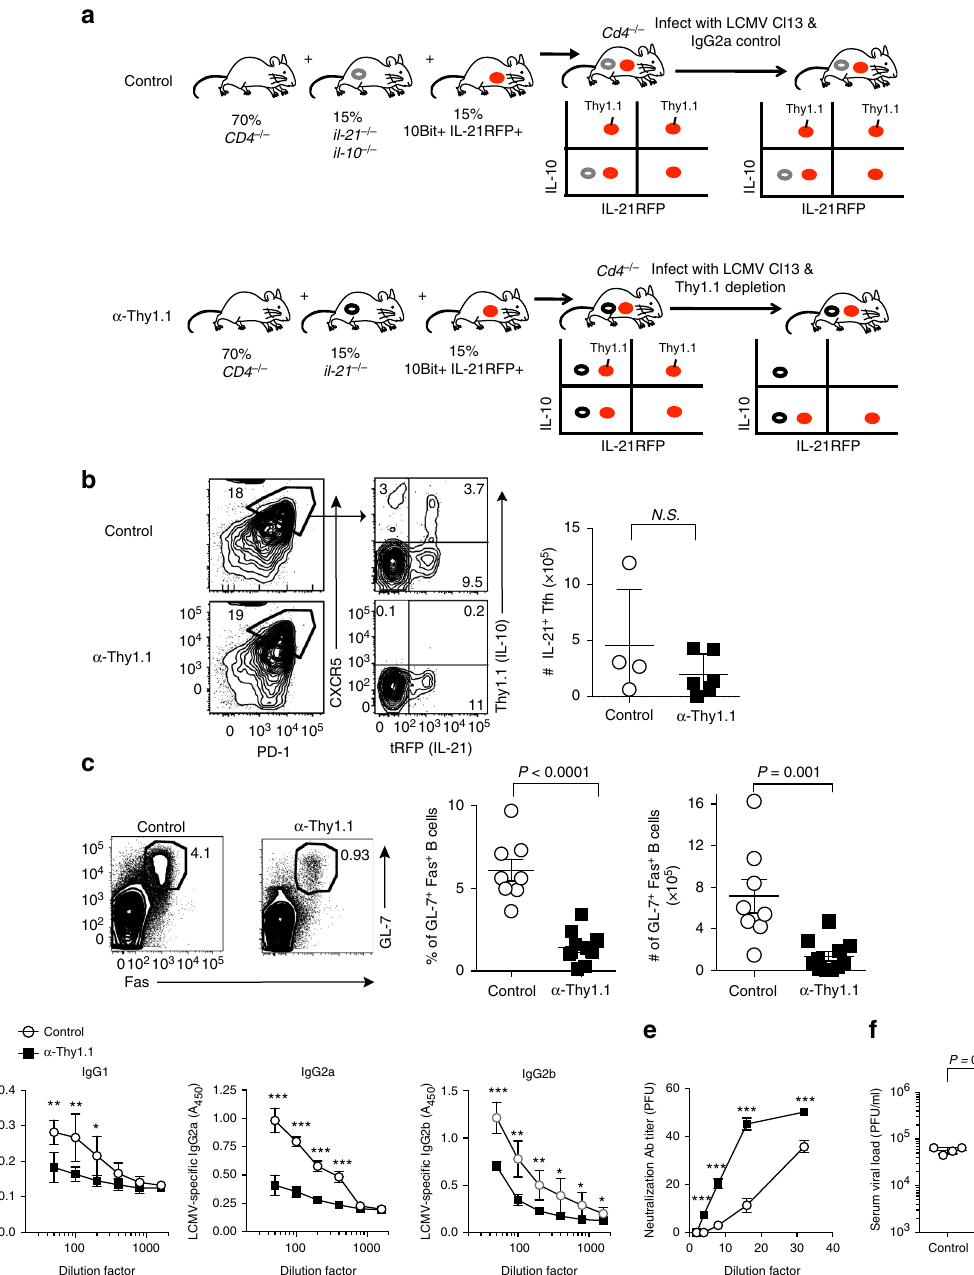
Fig. 3 IL-10 + IL-21 + CD4 T cells promote humoral immunity during chronic LCMV. a Experimental scheme showing the generation of MBM chimeric mice and the strategy to delete IL-10 + IL-21 + co-producing CD4 T cells. Brie fl y, CD4 − / − mice were lethally irradiated and reconstituted with bone marrow cells from the indicated donors at the ratios indicated. Red dots in the schematic represent bone marrow cells derived from 10BiT-Il21-RFP donor mice. Gray dots and black dots represent bone marrow derived from il-21 − / − IL-10 − / − and il-21 − / − donor mice respectively. The tables (right) indicate all of the potential IL-10 and IL-21-producing CD4 T cell compartments that bone marrow derived from the indicated donor mice can give rise to. b - f MBM mice were infected with LCMV Cl13 and treated with either Thy1.1 depletion or isotype control antibodies on days 4 and 6 p.i. b , c Representative fl ow plots and summary data showing the frequency and total number of Il-21 + CXCR5 + PD-1 hi Tfh cells ( b ) and GL-7 + Fas + GC B cells ( c ) on day 21 p.i. ( d ) Summary graphs of LCMV- speci fi c serum IgG1, IgG2a, and IgG2b antibodies. e Summary graph showing relative antibody neutralization titers for control and Thy1.1-depleted mice. f Viral titers were quanti fi ed by plaque assay using serum from experimental mice. Summary data (mean + /- SD in b ) or (mean + /- SEM in c - f ) are from 4 to 6 mice/group per experiment and are representative of two independent experiments. * P < 0.05, ** P < 0.01, *** P < 0.0001, (N.S. = not signi fi cant). Data were analyzed using two-tailed unpaired student ’ s t tests. See also Figure regression analyses demonstrated that virus-speci fi c antibody control MBM mice is likely humoral-mediated. Collectively, these titers inversely correlated with viral load (Supplementary Fig- data demonstrate that IL-10 + IL-21 + co-producing CD4 T cells ure 4C), indicating that the enhanced protection observed in are critical for sustaining GC reactions, promoting B cell